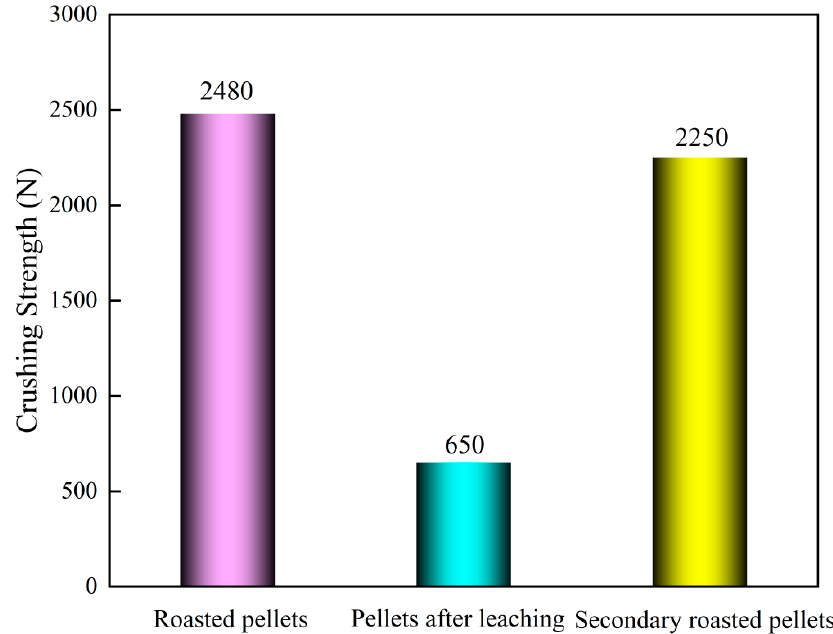
Figure 9. Pellet crushing strength of roasted pellets, pellets after leaching and secondary roasted pellets.